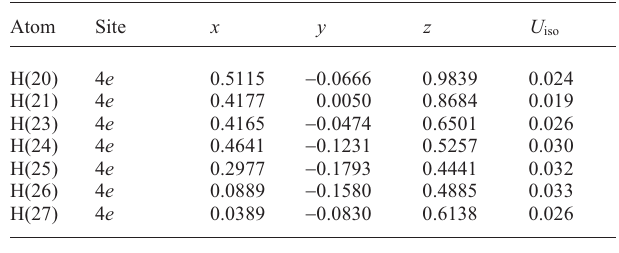
Table 3. Atomic coordinates and displacement parameters (in Å 2 )